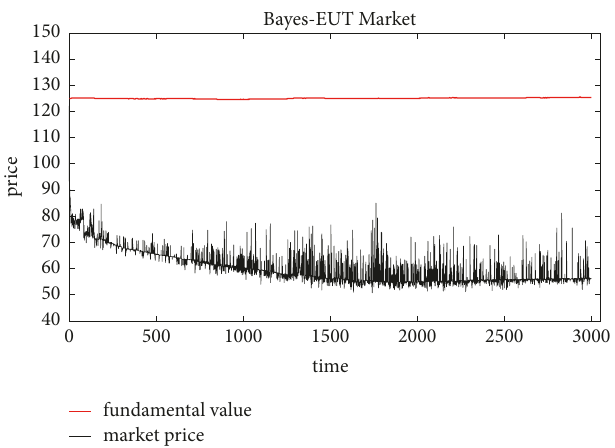
Figure 1: Varying curve of the market price considering the assumptions of Bayes-EUT model.